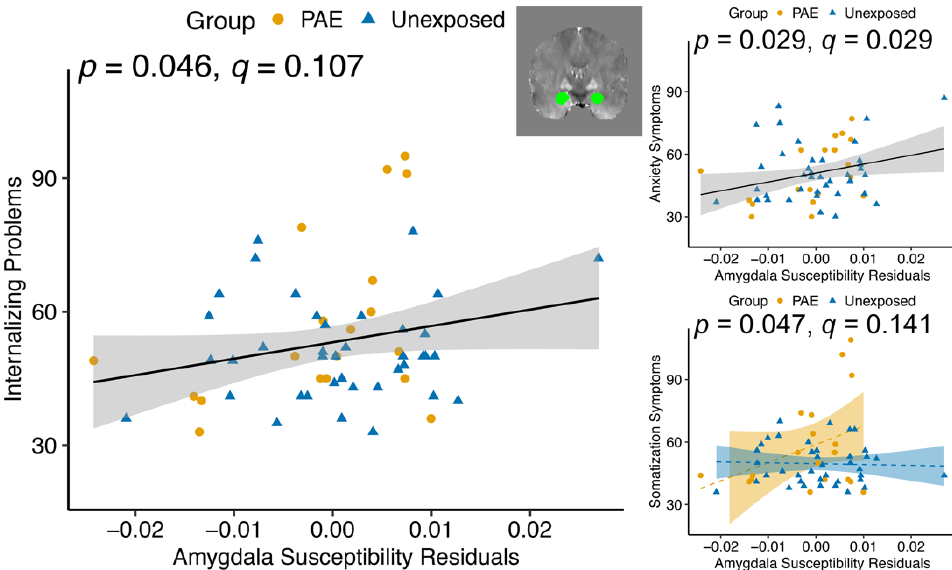
Figure 2. Nucleus accumbens (NAcc) magnetic susceptibility was negatively associated with BASC- 2-PRS T scores Internalizing Problems, Depression, and Anxiety symptoms in youth with and with- out PAE. The p values indicate the main effect of susceptibility on Internalizing Problems, Depres- sion, and Anxiety, and susceptibility values are corrected for age and gender.